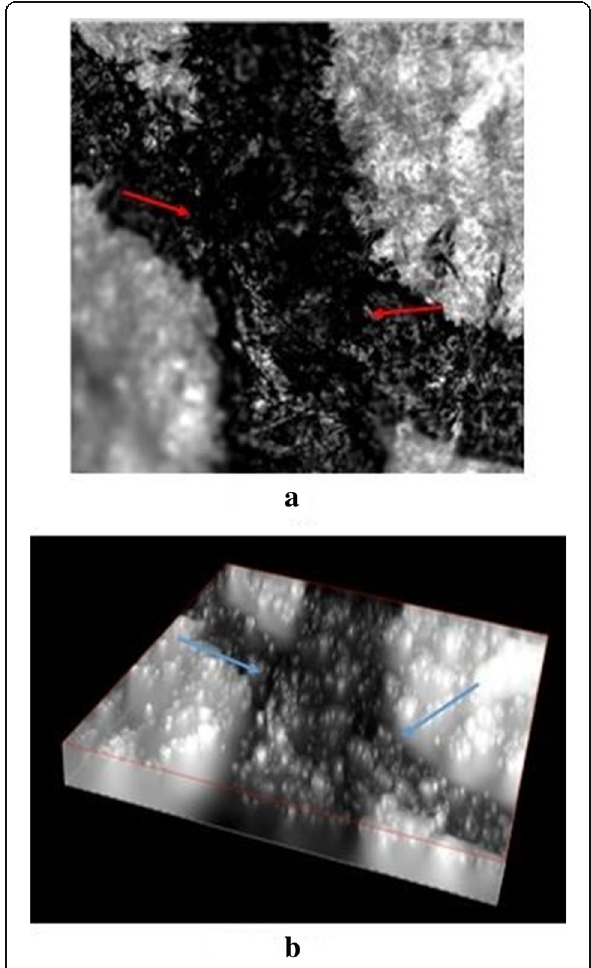
Fig. 5 Black Cello Pinpoint pen intersecting strokes. a 2D figure. b 3D figure